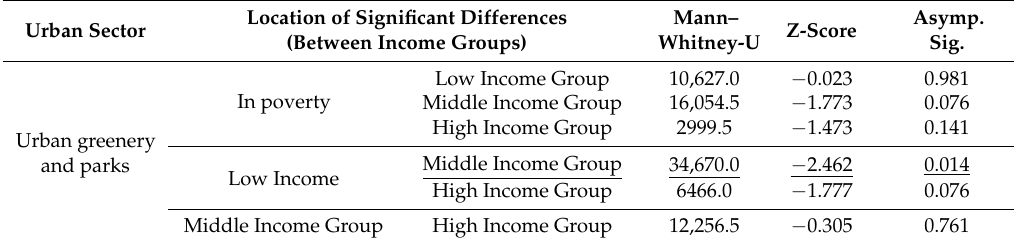
Table 5. Results of Mann–Whitney U-test in regard to the importance of urban sectors in heat wave adaptation. The underlined text shows the location of significant differences between income groups with p -value less than